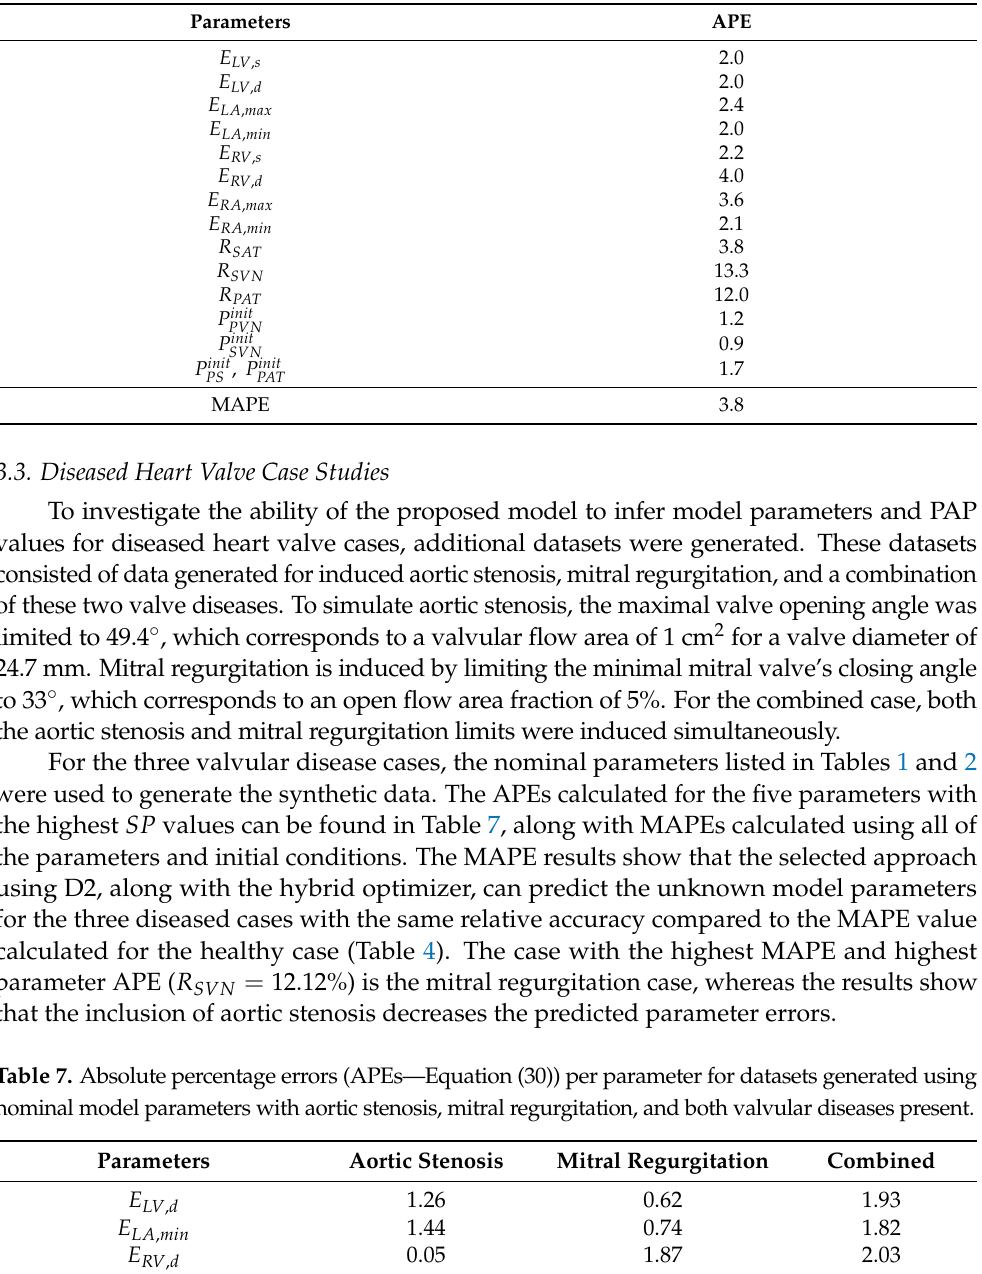
Table 6. Absolute percentage errors (APEs—Equation (30)) per parameter using a dataset containing only ventricle volume and systemic arterial pressure waveforms (D3).